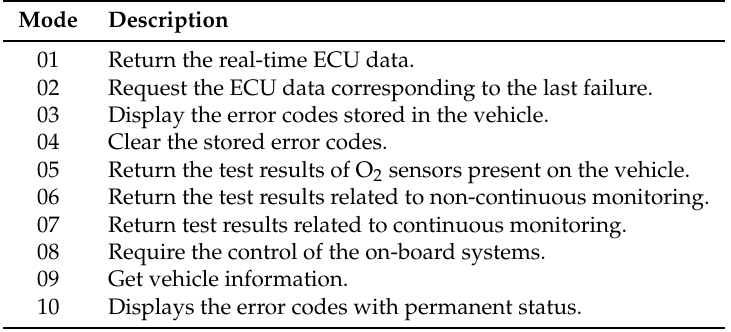
Table 2. Operation modes supported by OBD-II.